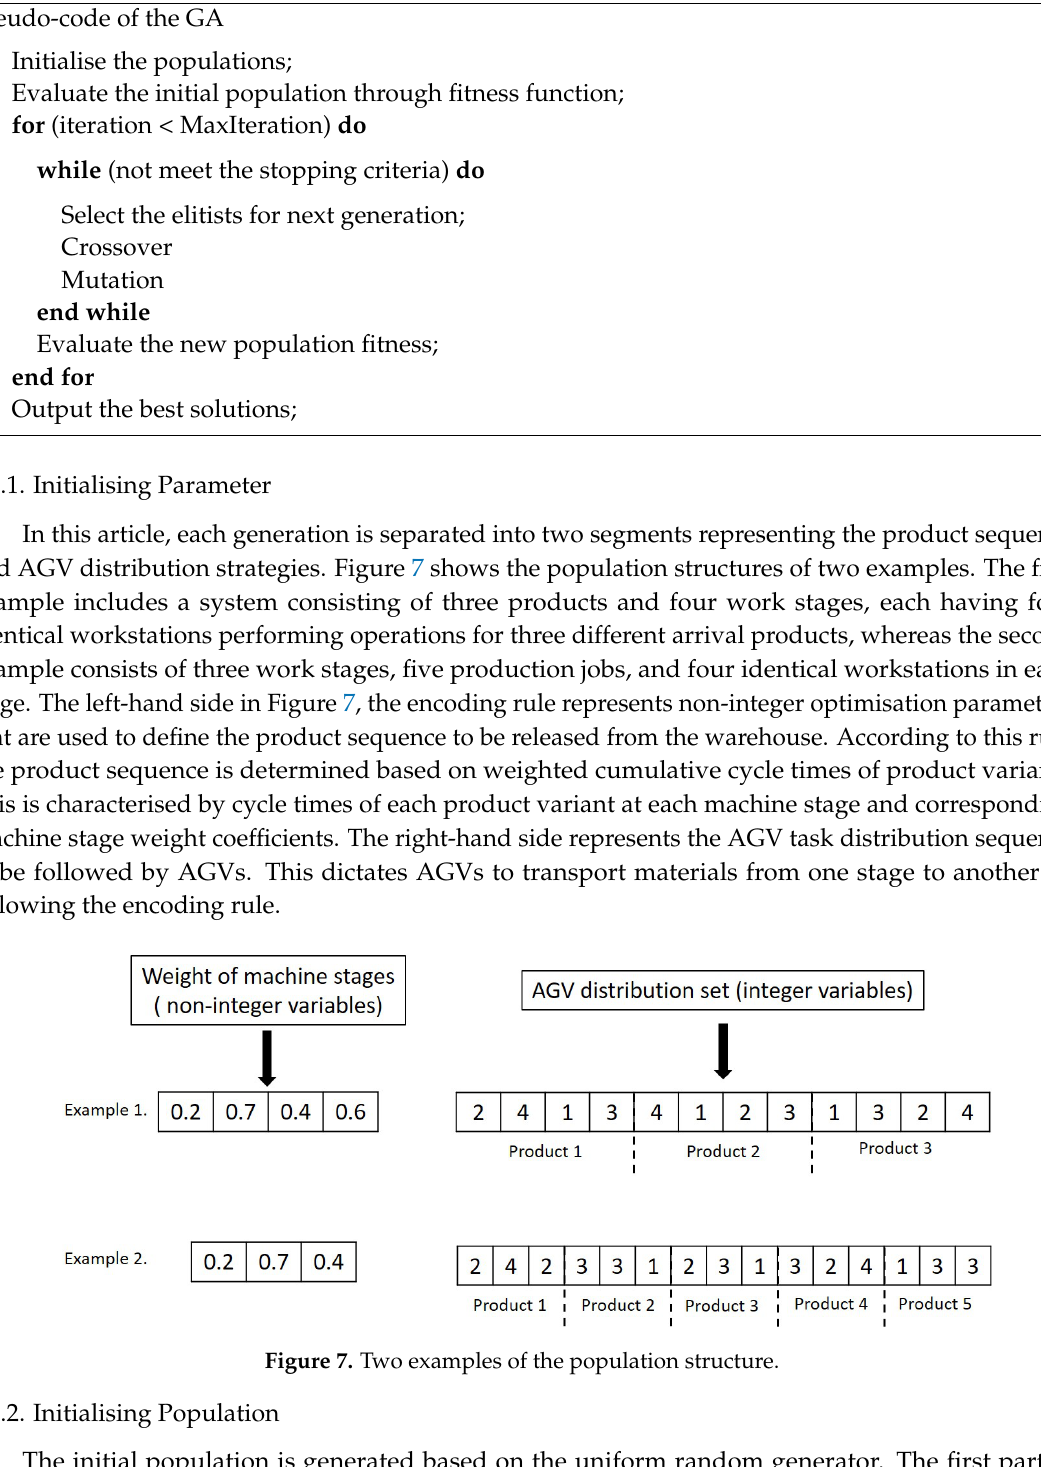
Algorithm 1 Genetic Algorithm pseudo-code. Pseudo-code of the GA